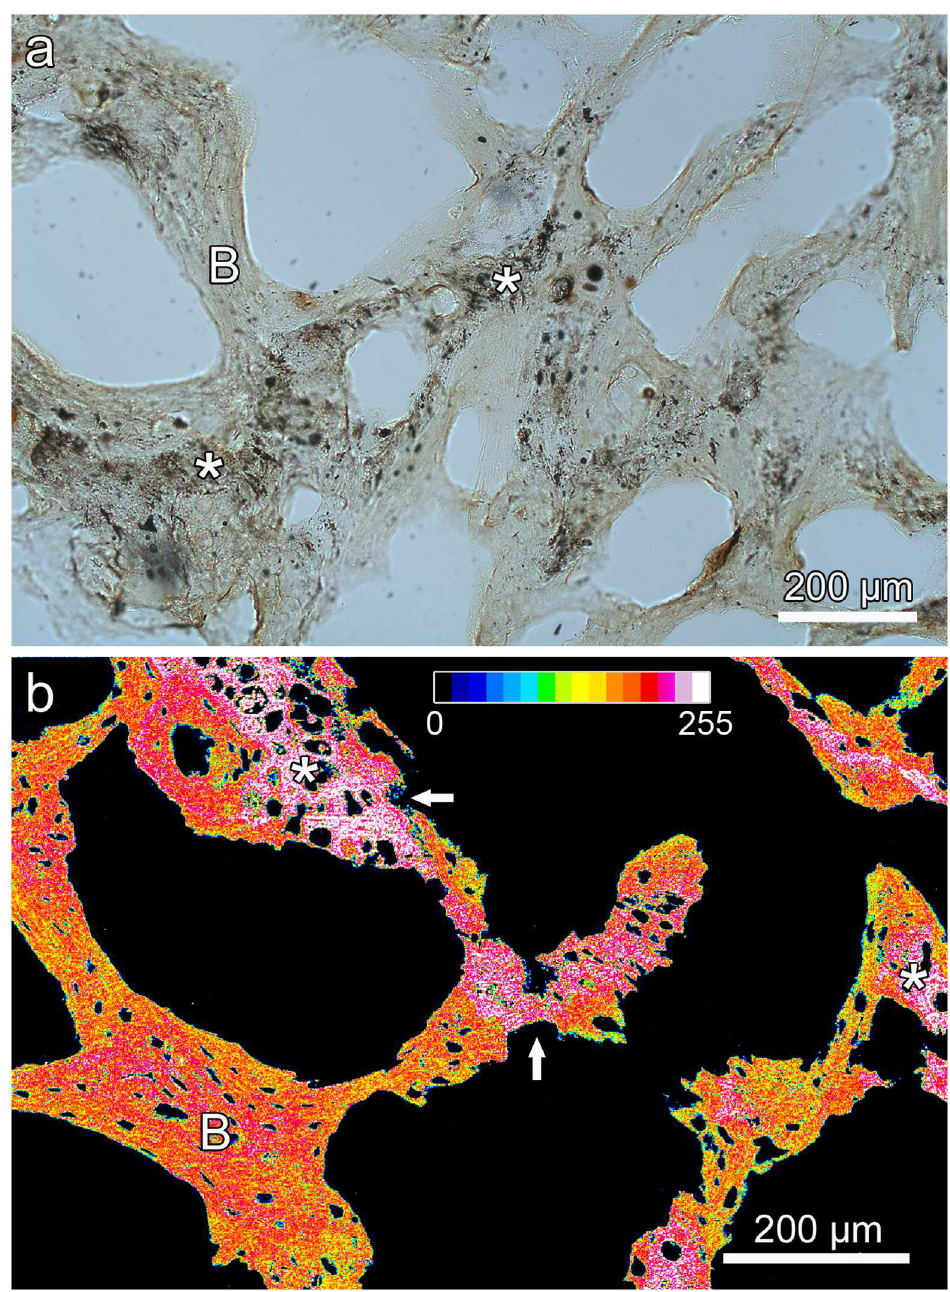
Fig 7. Images showing mineralized cartilage (asterisks)and bone (B) in the exostoses on the left zygomatic bone and right antler of the white-tailed buck ( Odocoileus virginianus ). ( a ) Micrographof groundsection, showingthe central portion of the exostosis arising from the left zygomatic bone; plain transmitted light. ( b ) Pseudo-color BSE image of the tip regionof the smaller exostosis arising from the right antler (depicted in Fig 2A). The gray levels from black (0) to peak white (255) obtainedin the SEM were sequentially combinedinto16 bandsof equal width, each represented by a different color (see inserted color bar). Higher values indicatehigherdegreesof mineralization. The mineralized cartilageshows a higher degreeof mineralization than the adjacent bone. Note also the larger size, more variableshape and more irregulararrangementof the chondrocytelacunaecomparedto the osteocyte lacunae. Arrows: resorption pits in mineralized cartilage.